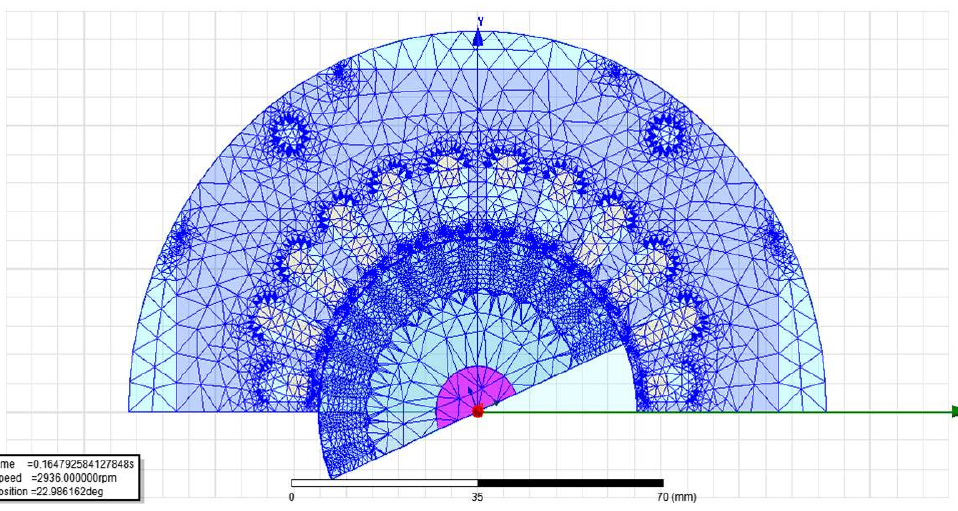
Figure 4. Mesh plot of IM model at 22°.